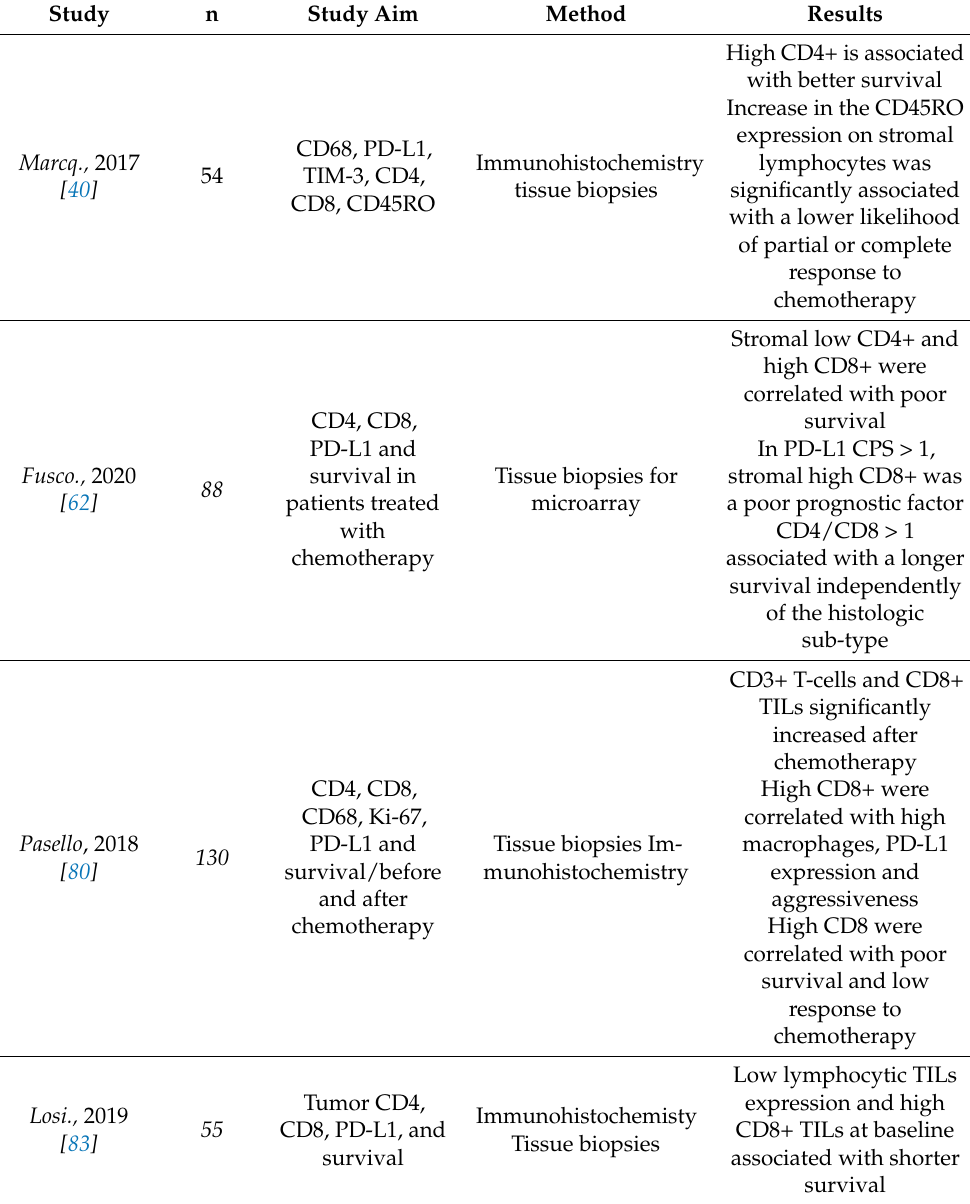
Table 2. Studies assessing the adaptative immune cells microenvironment of